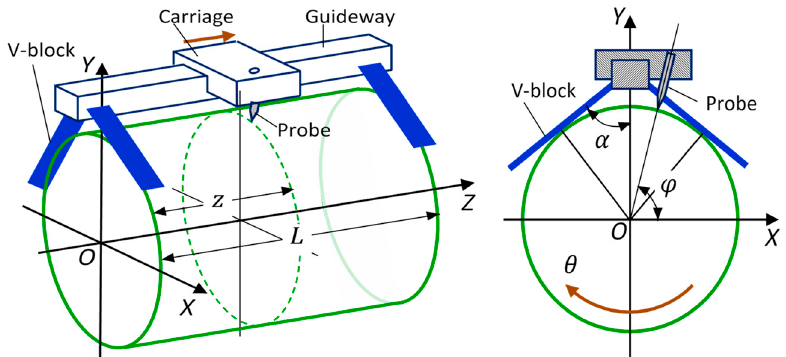
Figure 5. Schematic of V-block scan EST [1,12,13]. The left shows the measured cylinder in the OXYZ system; the right shows the cross-section of the cylinder in the plane of the